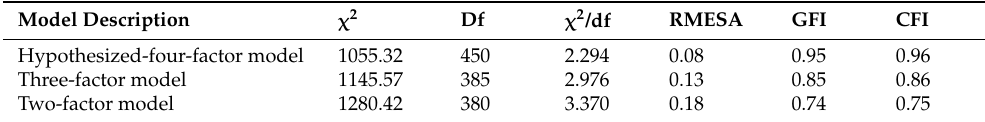
Table 2. Confirmatory Factor Analysis